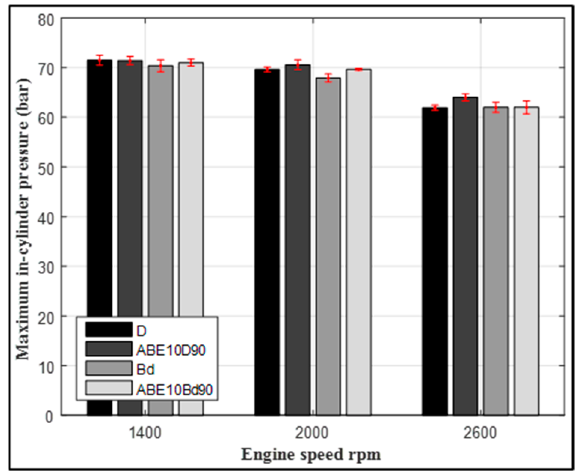
Figure 7. Maximum in-cylinder pressure test fuels.